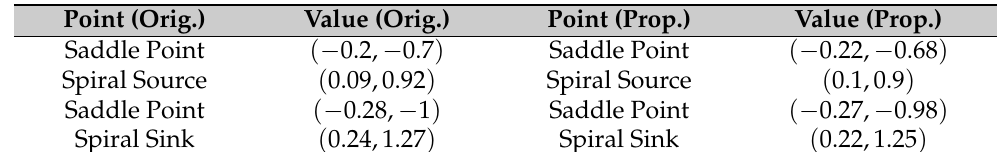
Table 3. Equilibrium Points For the Original and Proposed Models.